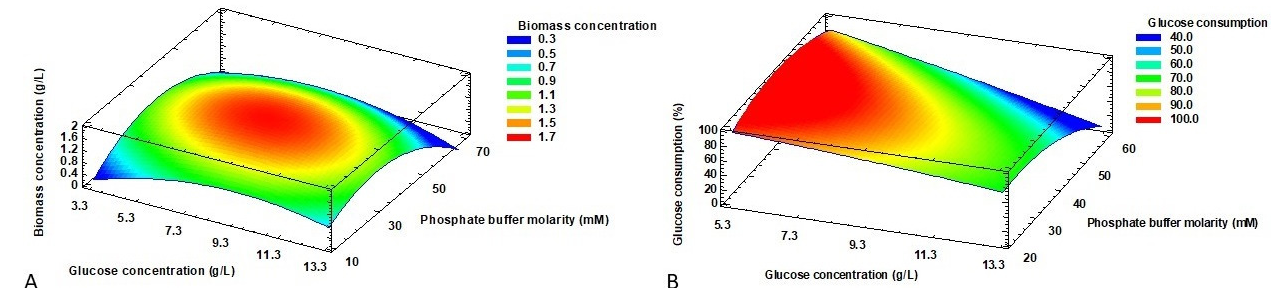
Figure 3. Response surface model plots showing the effects of the phosphate buffer molarity and the glucose concentration on the biomass concentration ( A ) and the carbon consumption ( B ). The optimal value of the sodium ammonium phosphate concentration was set as a constant.